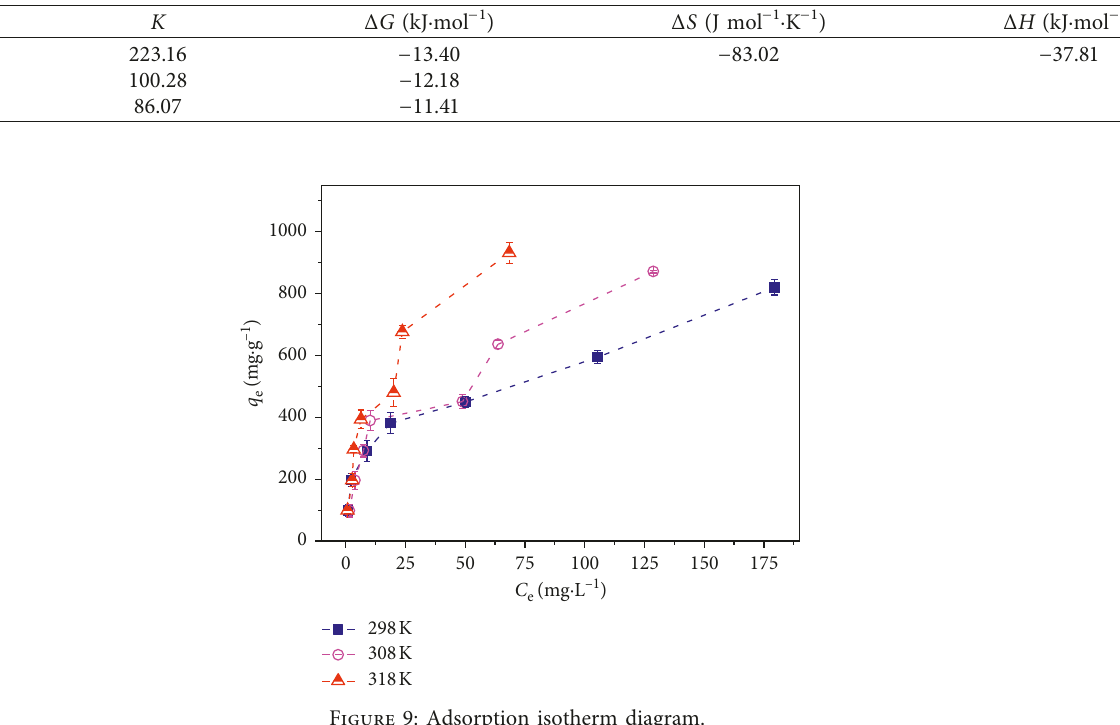
Table 4: Calculated thermodynamic parameters.